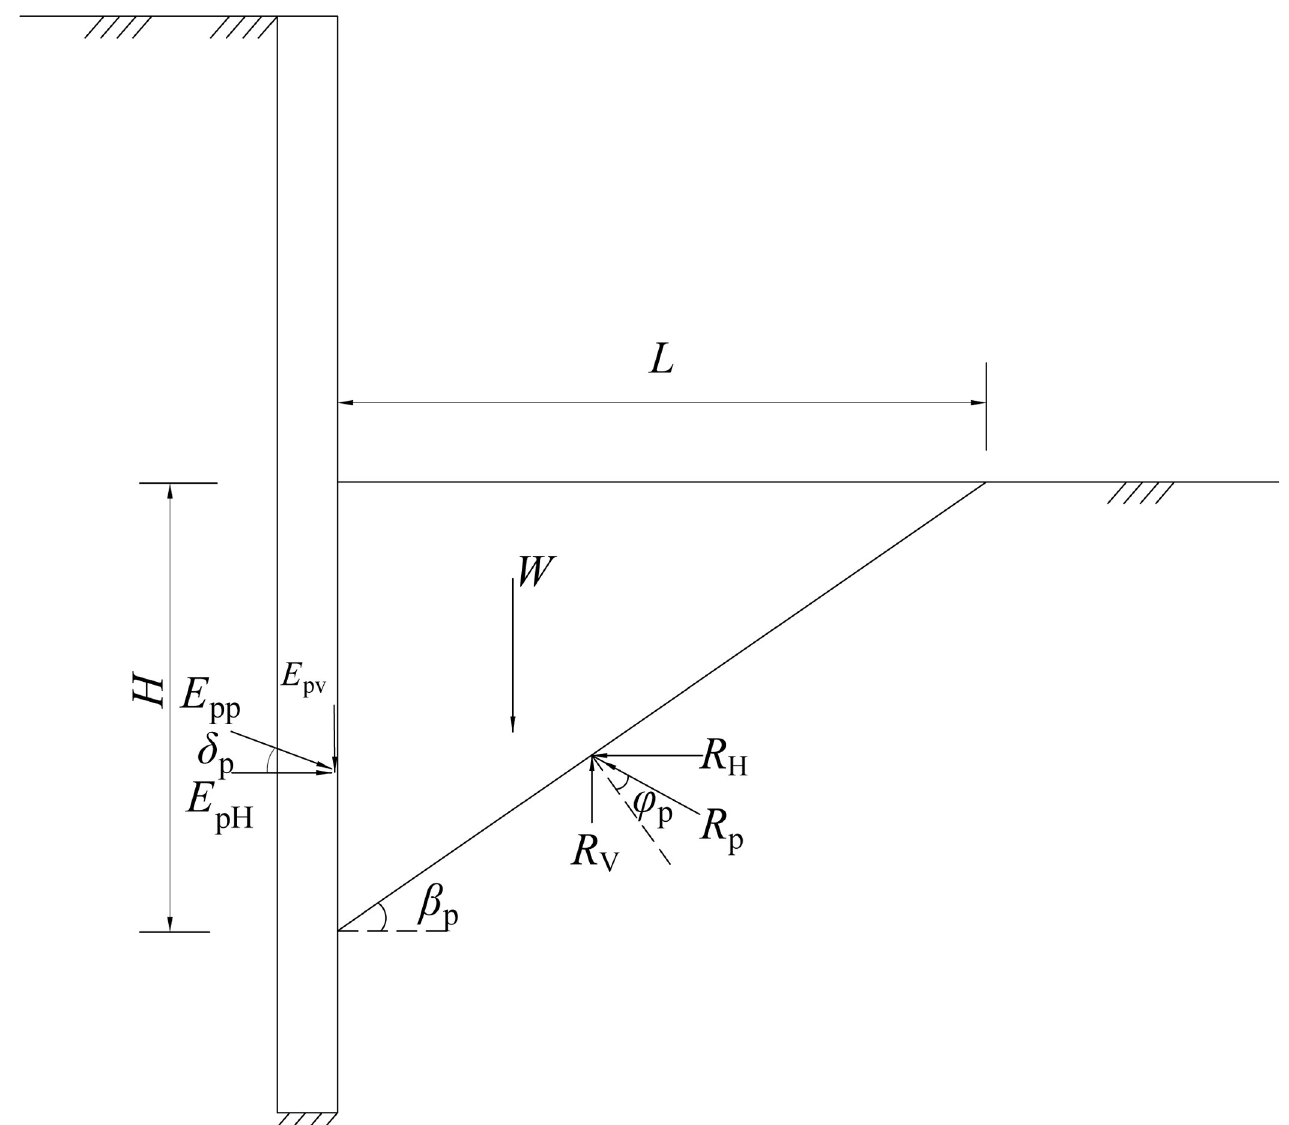
Fig 13. Stress mechanism of soil wedg (limit passive